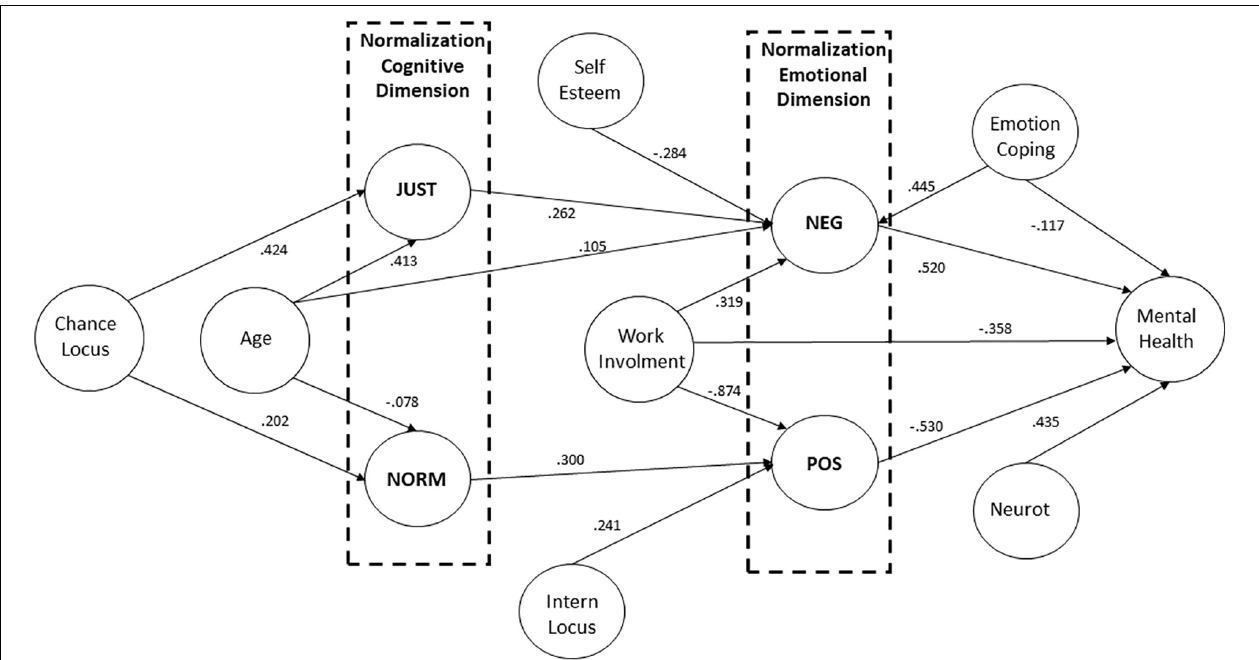
FIGURE 3 | Path analysis of the unemployment normalization. JUST: unemployment justifications; NORM: unemployment norm; NEG: negative perceptions; POS: positive perceptions; Neurot: